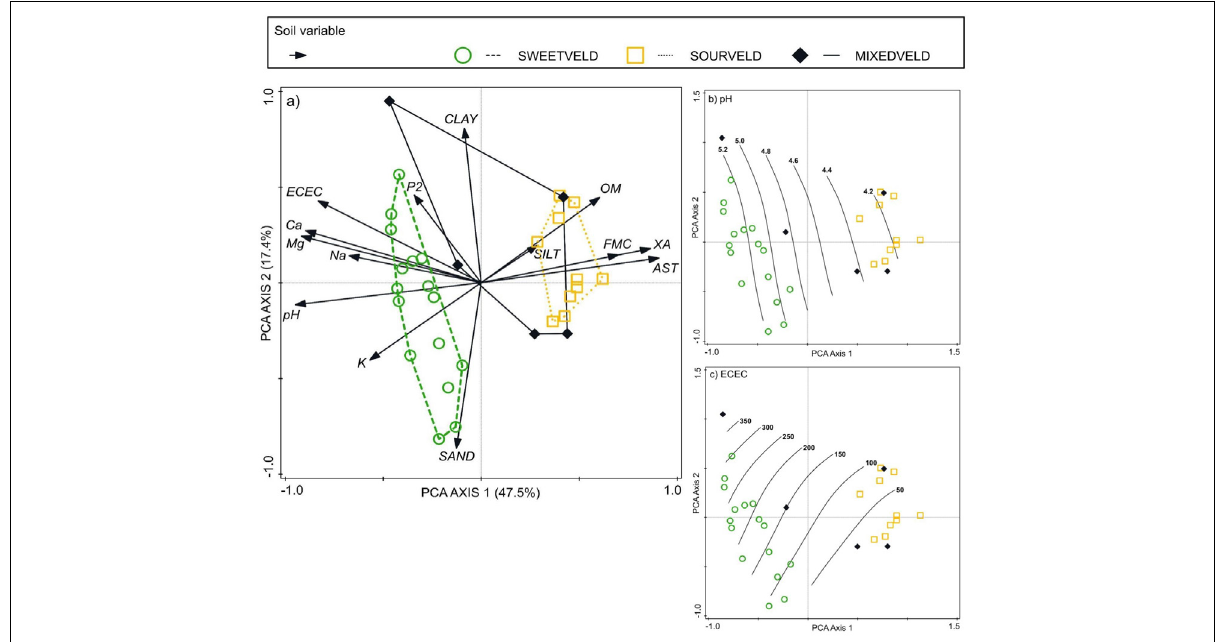
AST, acid saturation; ECEC, effective cation exchange capacity, FMC, field moisture capacity; OM, organic matter; XA, exchangeable acidity Figure 2: First two axes of a correlation-type principal component analysis (PCA) of topsoil variables measured at 31 locations in three grassland types in